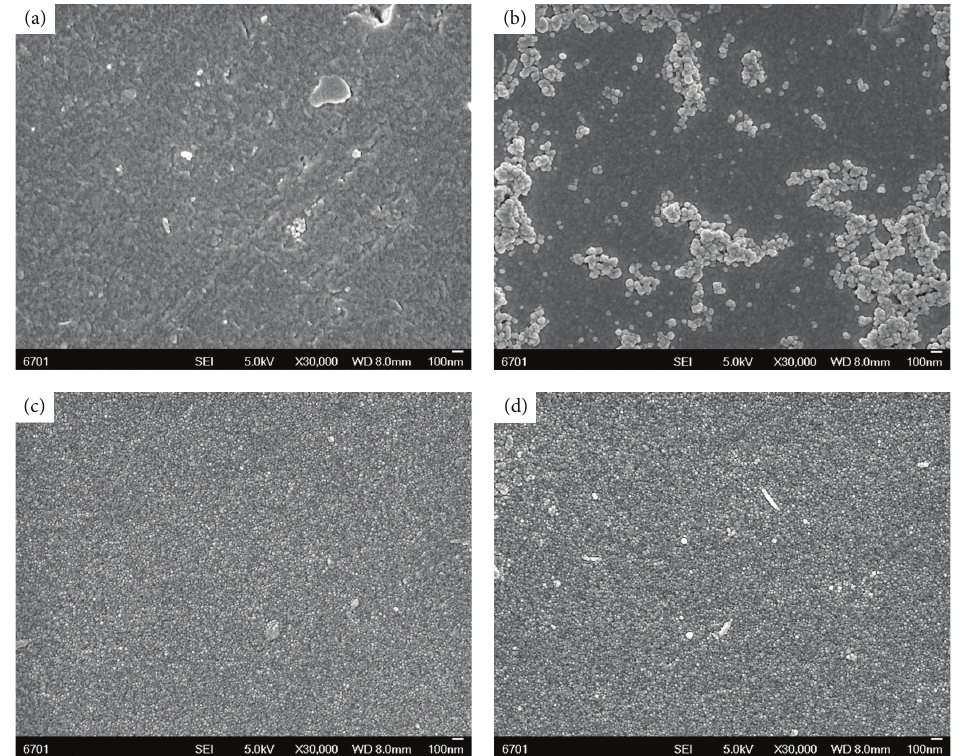
Figure 6: SEM images of M-PAANa prepared at different reaction times: (a) 10 min, (b) 0.5 h, (c) 1h, and (d) 8 h.